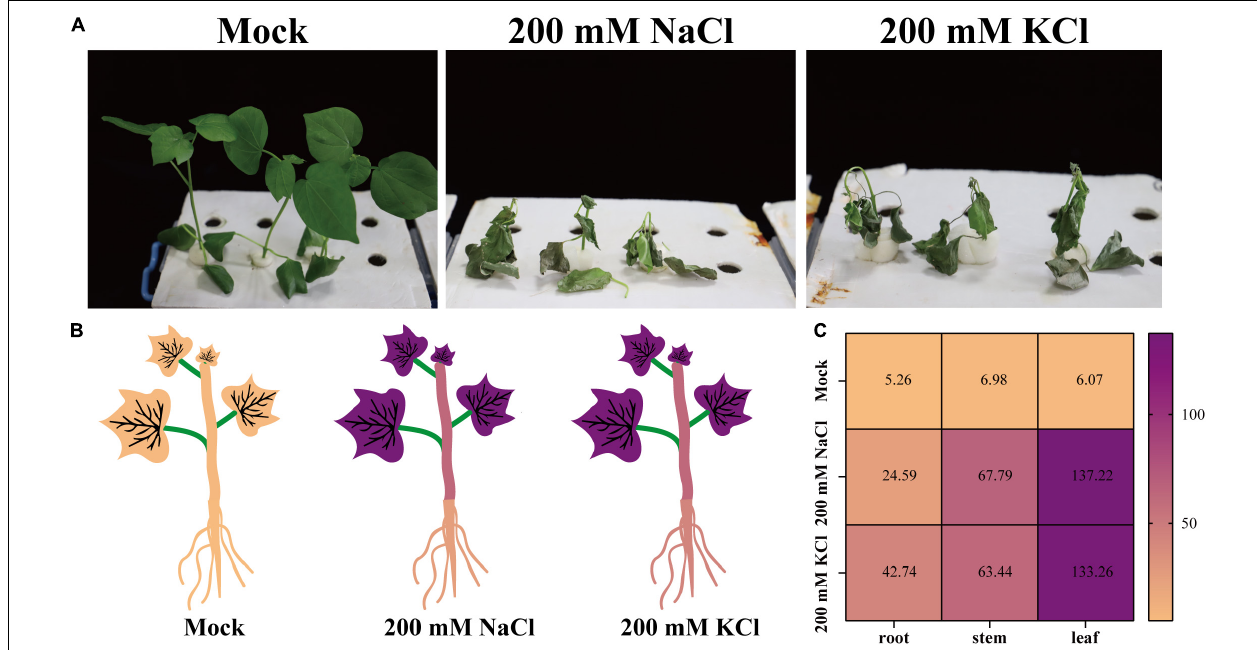
FIGURE 1 | The resulting phenotypes and chloride uptake of upland cotton plants treated with NaCl or KCl. (A) Phenotypes of upland cotton plants treated with no chloride (Mock), 200 mM NaCl, or 200 mM KCl for 10 days. (B) Cl − contents (mg/g DW) of upland cotton plants (roots, stems, and leaves) treated with no chloride (Mock), 200 mM NaCl, or 200 mM KCl for 10 days. (C) Heatmap of the Cl − contents of upland cotton plants treated with no chloride (Mock), 200 mM NaCl, or 200 mM KCl. The Cl − concentrations are indicated by different colors and the colors are consistent in panels (B,C)